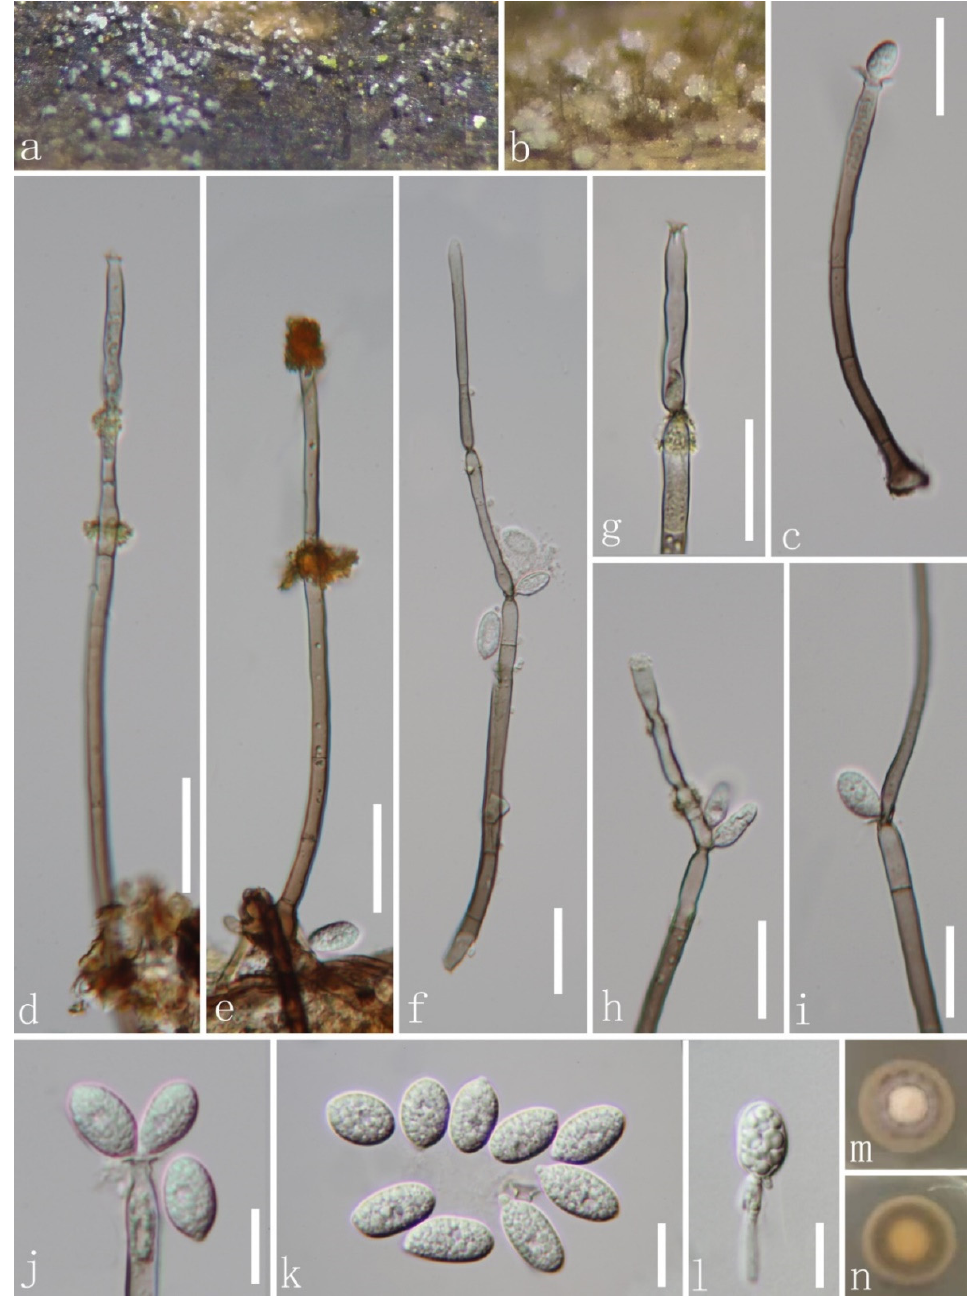
Figure 2. Chaetosphaeria obovoidea (HKAS 123765, holotype). ( a , b ) Colonies on woody substrate; ( c – f ) conidiophores with pale gold or red appendant attached; ( g – j ) conidiogenous cells; ( j – l ) conidia; ( l ) germinating conidium; ( m , n ) culture on PDA from above and below. Scale bars: ( c – f ) 25 μ m; ( g – i ) 20 μ m; ( j – l ) 10 μ m.